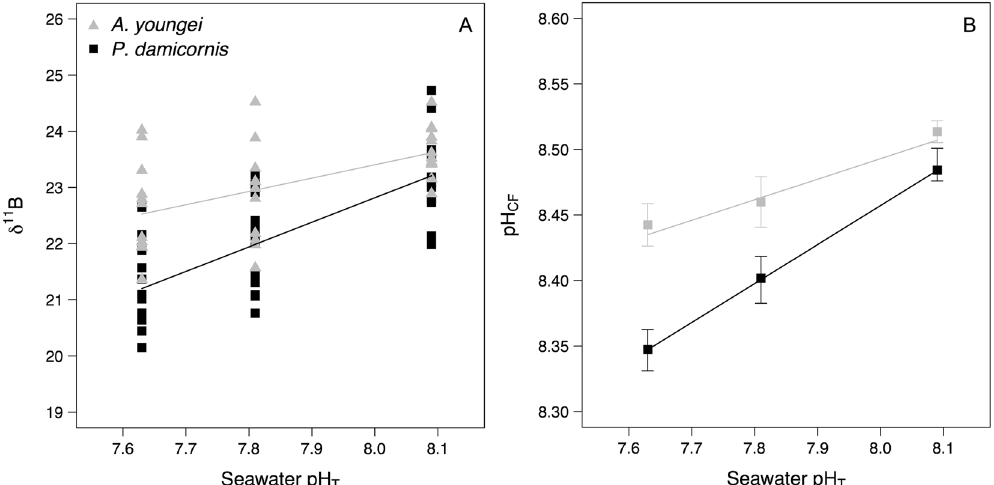
Figure 2. δ 11 B and estimates of pH in the calcifying fluid (pH cf ) determined on the corals Acropora youngei (grey triangles) and Pocillopora damicornis (black dots) incubated during 8 weeks under pH = 8.09, 7.81, and 7.63. For both corals, the relationships between δ 11 B and seawater pH were best fit with linear models ( δ 11 B = 2.37 pH SW + 4.41, p < 0.001, and δ 11 B = 4.37 pH SW − 12.11, p < 0.001, for A . youngei and P . damicornis , respectively). Therefore, the relationships between pH cf and seawater pH also were best fit with linear models (pH cf = 0.157 pH SW + 7.24, p < 0.001, and pH cf = 0.30 pH SW + 6.08, p < 0.001, for A . youngei and P . damicornis , respectively). Values displayed for δ 11 B are individual replicates and are mean ± SE (n = 12) for pH cf . Uncertainty on pH cf estimates was 0.01 pH unit.